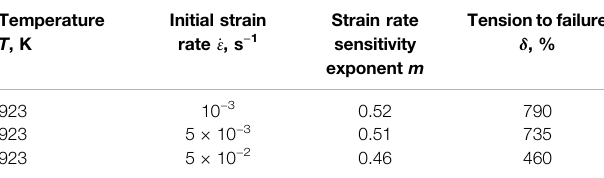
TABLE 3 | Results of m and tension rate δ of Ti-6Al-4V at 923 K and different tension